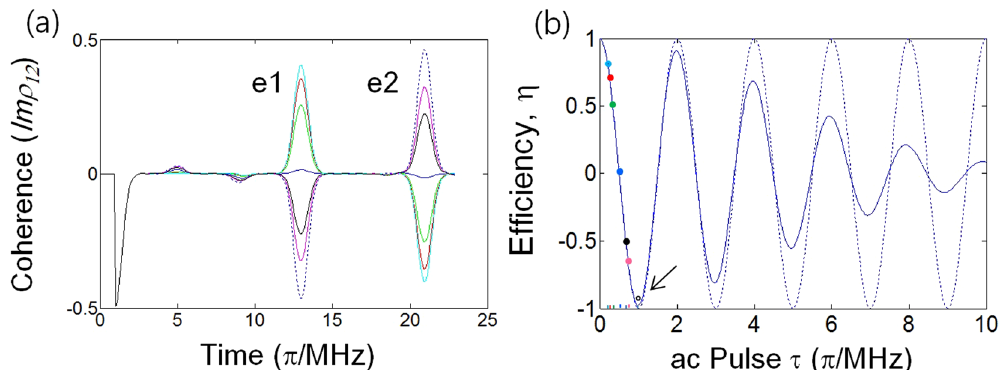
Figure 2. ac Stark influence on photon echo efficiency. The pulse sequence for ( a ) is in Fig. 1b. e1 and e2 are the echoes by R1 and R2, respectively. All parameters are the same as in Fig. 1, unless otherwise specified. The generalized ac Stark Rabi frequency is Ω′ = . MHz 1 02 , where Ω = MHz 1 and ∆ = MHz 5 . ( a ) The ac AC AC Stark photon echoes for different ac Stark Rabi frequencies, Ω ′ AC , with a fixed pulse duration of τ = 0.1 μ s . For N Φ Ω τ = ′ , the different curves are as follows: cyan (N = 5; Φ AC = π /5); red (N = 4; Φ AC = π /4); green (N = 3; AC = π /3); blue (N = 2; Φ = π /2); black (N = 3/2; Φ = 2 π /3); magenta (N = 4/3; Φ = 3 π /4); dashed (N = 1; Φ AC AC AC AC = π ). ( b ) The ac Stark echo efficiency model based on equation (1). The solid curve is the overall echo Φ AC ACj and the c efficiency η for Eq. (1), where η = ∑ Φ c cos( ) j are the weight factors for Gaussian distribution. The j j colored dots are the results from ( a ) for different Φ AC . The dotted curve is a reference for the resonant atom ( δ 0 ) at line